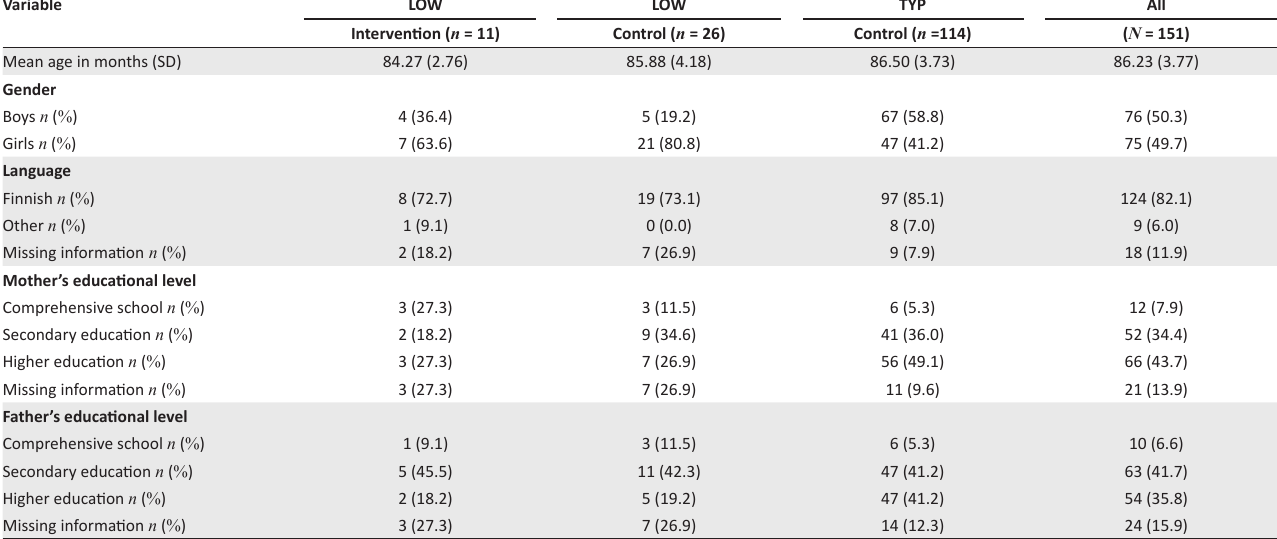
TABLE 1: Demographic descriptives (age, gender, language and parental educational level) by group. Variable